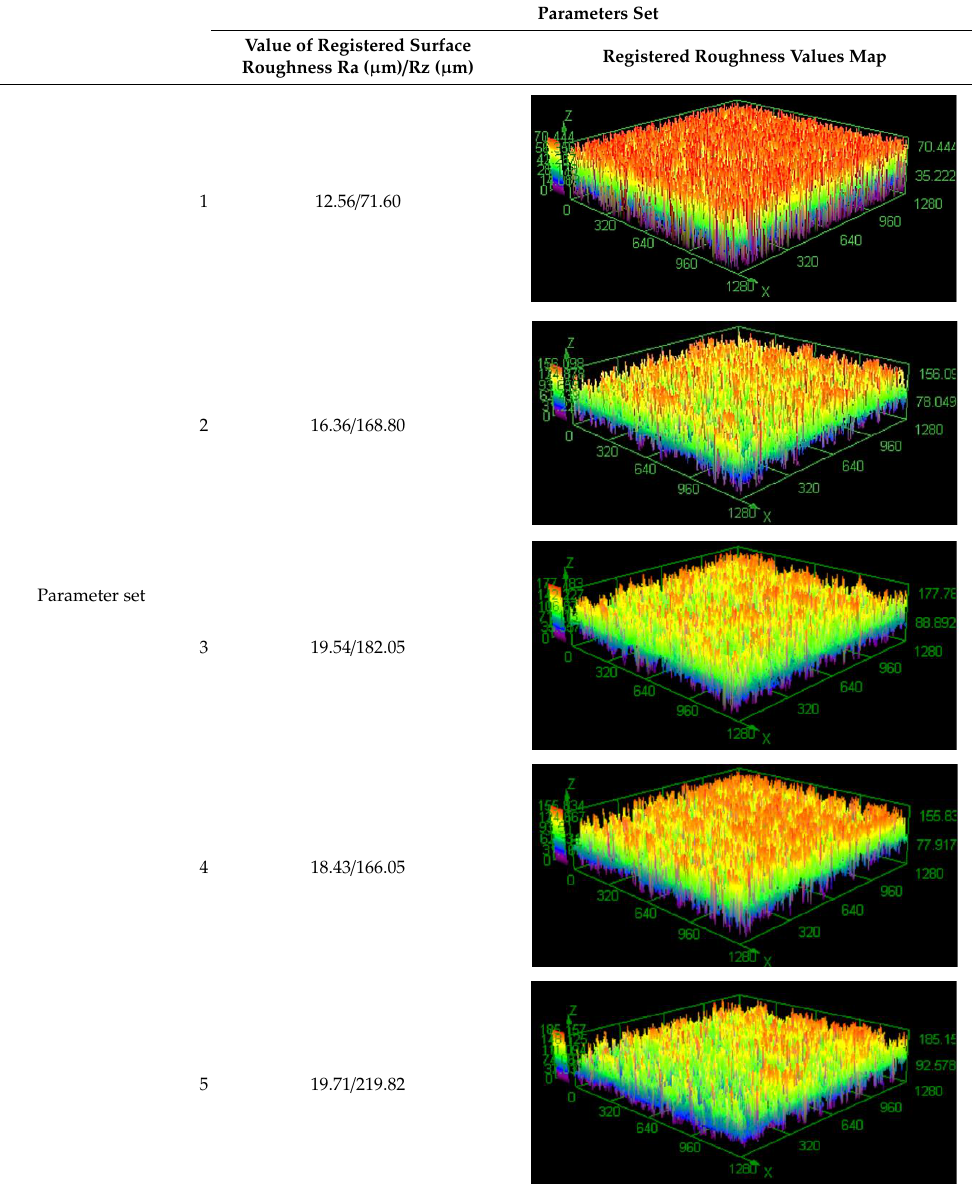
Table 5. Surface roughness in samples 1 – 5.